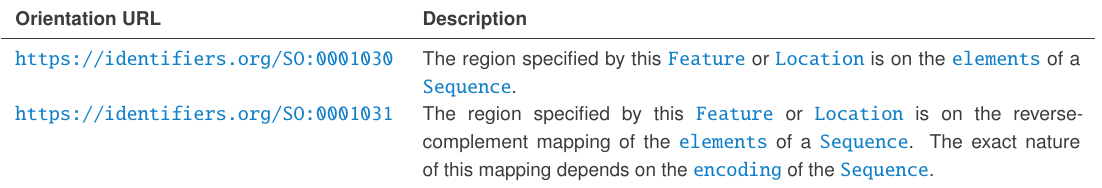
Table 5: RECOMMENDED URL s for the orientation property